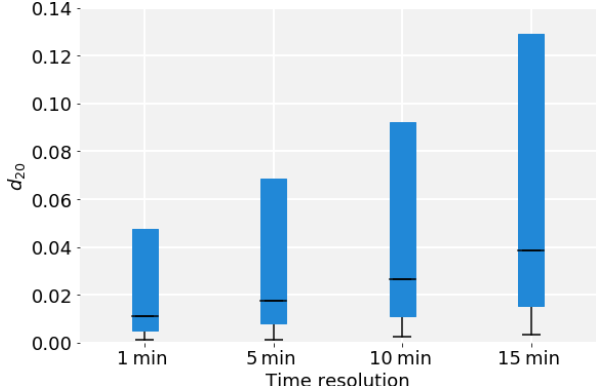
Figure 7. Comparison of the distribution of d 20 for different time resolutions over 10 years. The bars extend from the 25th to the 75th percentiles; the minimum and median of the distributions are indi- cated in black. Note that the maxima are higher than the graph range and therefore not